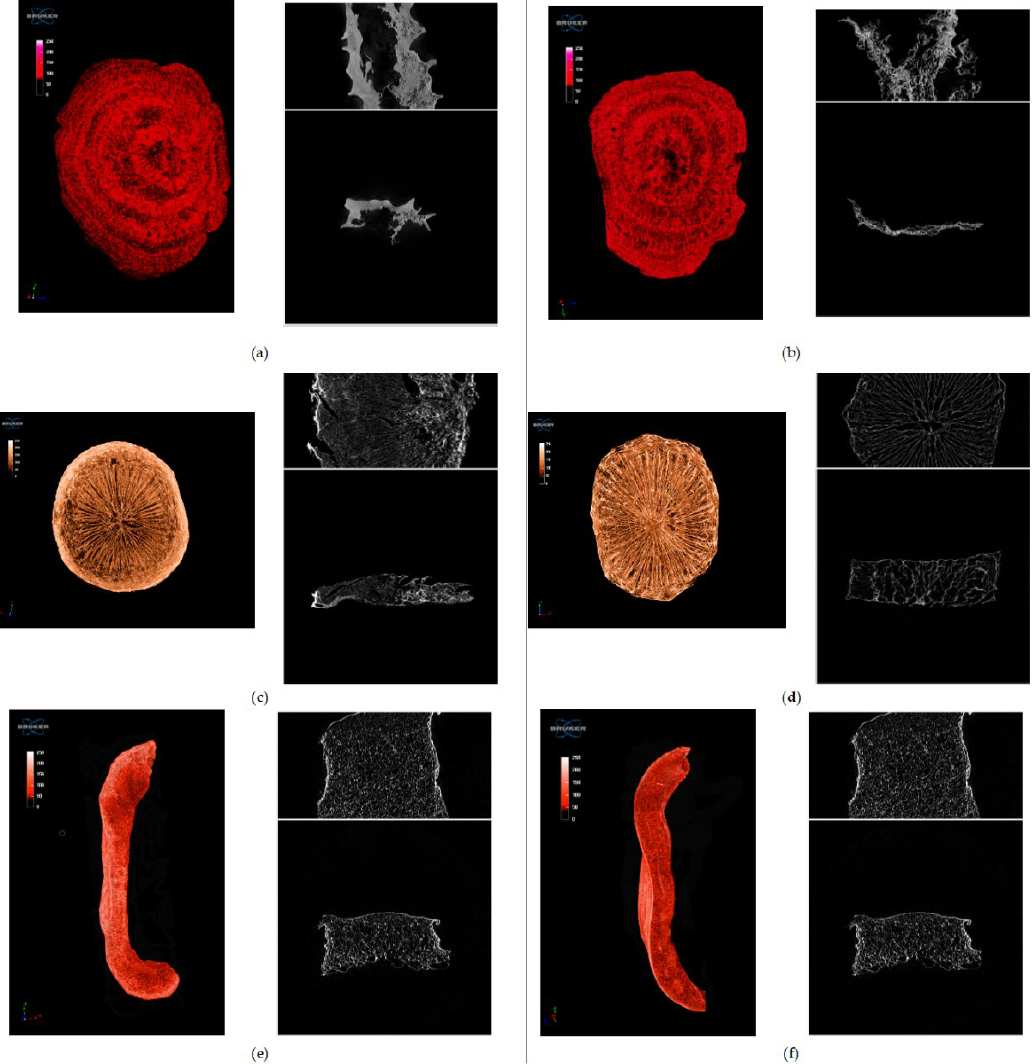
Figure 4. Structure of freeze-dried unfermented and fermented vegetables (Microtomography) ( a ) unfermented beetroot; ( b ) fermented beetroot; ( c ) unfermented carrot; ( d ) fermented carrot; ( e ) unfermented red bell pepper; ( f ) fermented red bell pepper.